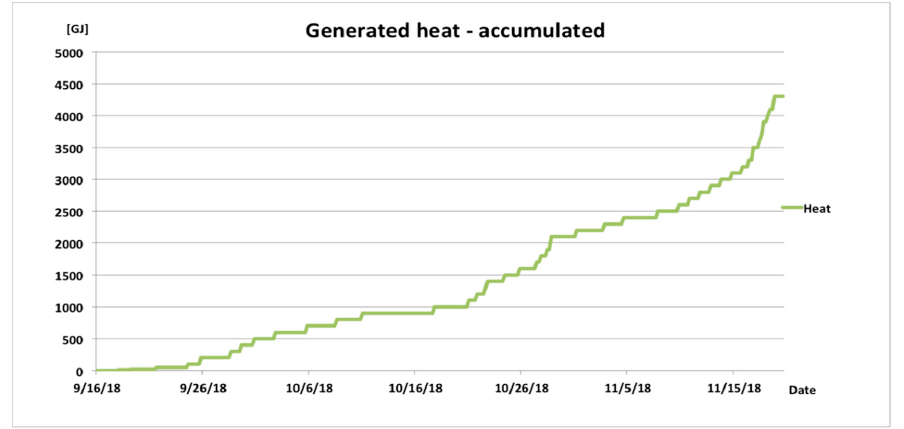
Figure 1. Heat characteristics data for the PSNC’s DC.